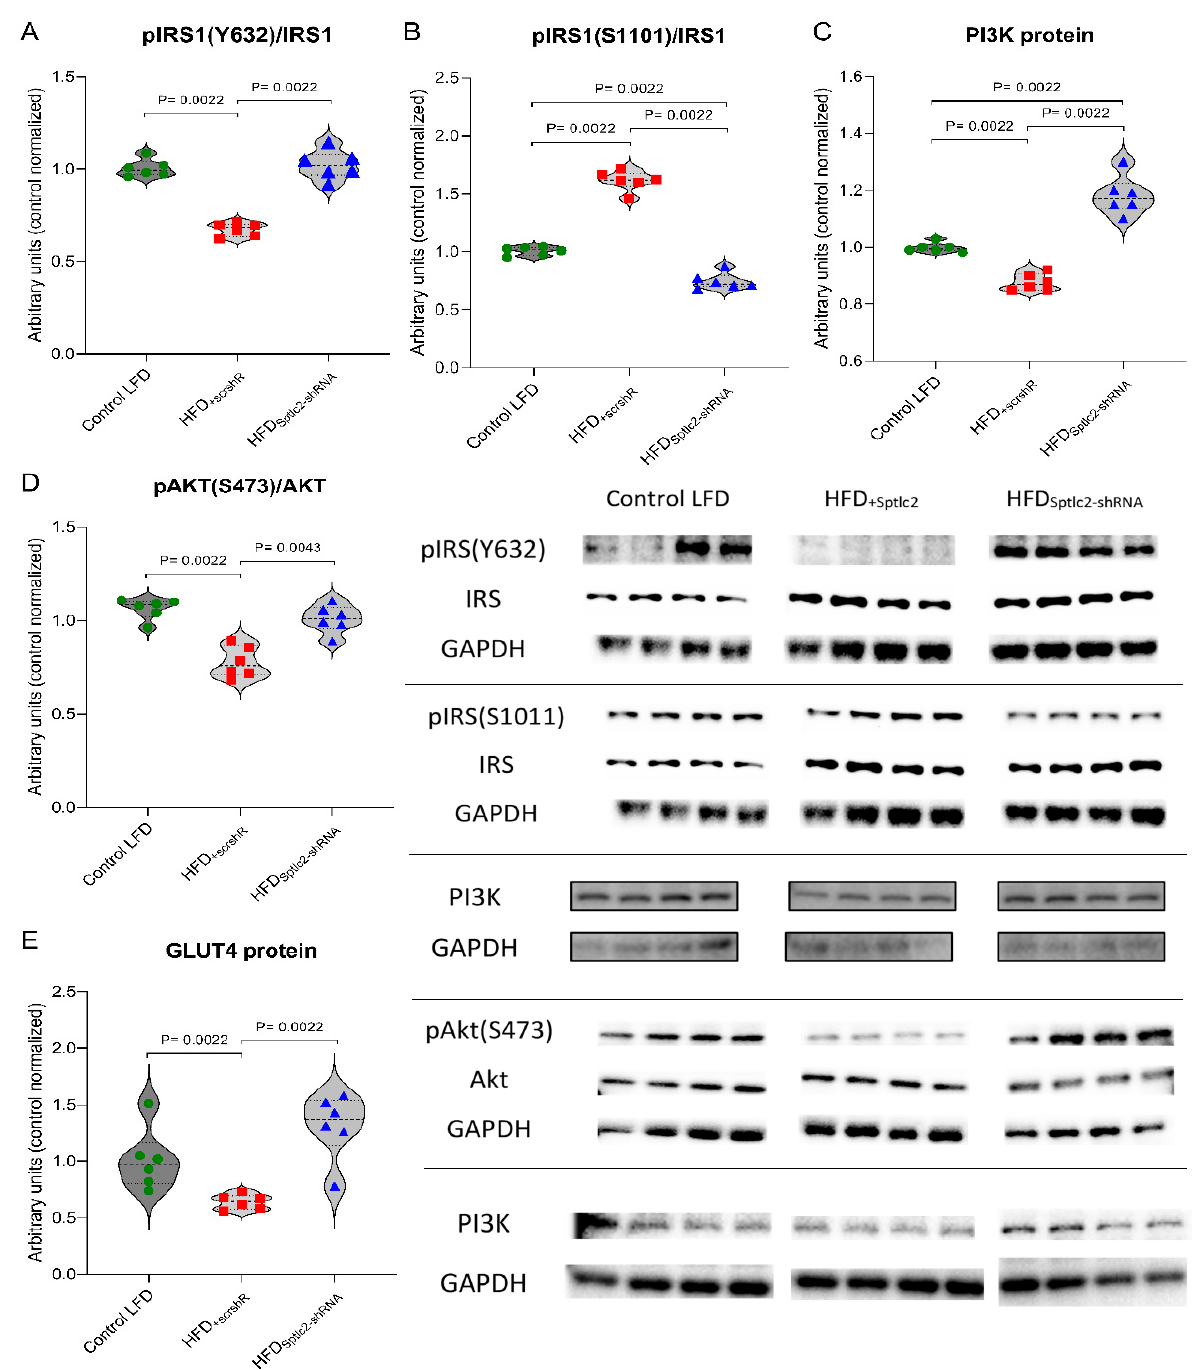
Figure 7. ( A – E ) Effect of Sptlc2 silencing on activation of insulin signaling pathways in the mouse gastrocnemius muscle: ( A ) insulin receptor substrate 1 (IRS1) tyrosine phosphorylation (pIRS1 Y632); ( B ) IRS1 serine phosphorylation (pIRS1 S1101); ( C ) protein expression of phosphoinositide 3-kinase (PI3K); ( D ) serine phosphorylation of protein kinase B/Akt (pAKT S473); ( E ) protein expression of glucose transporter 4 (GLUT4). Significance by Mann–Whitney U test. The figures show the median and interquartile range ( n = 6 per group). The observed molecular weights of the indicated proteins are different to the theoretical values, as stated by the antibody manufacturer. Green circles—values for individual Control LTD gastrocnemius muscles; Red squares—values for individual HFD +scrshRNA gastrocnemius muscles; Blue triangles—values for individual HFD Sptlc2-shRNA gastrocnemius